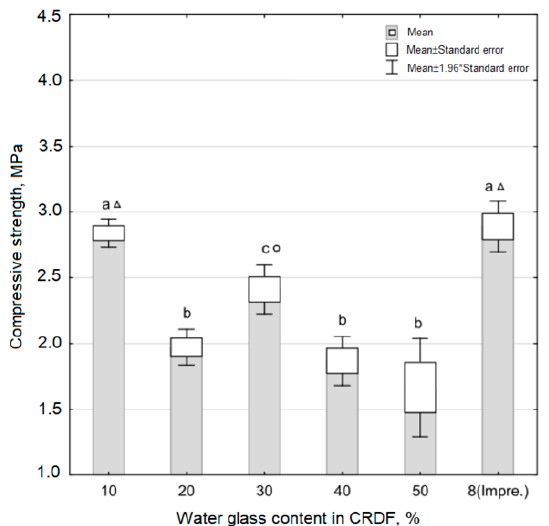
Figure 4. The compressive strength of carbonized refuse-derived fuel (CRDF) pellets produced at a pressure of 50.8 MPa depending on the water glass content in CRDF and coating of CRDF with water glass—letter designations ‘a–e’ denote statistically significant ( p < 0.05) differences between samples inside combination I, geometric markings statistically significant ( p < 0.05) differences between combinations I, II and III.